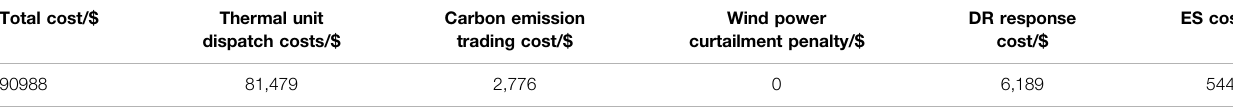
TABLE 5 | Daily operation costs of the system in Scenario 3 Total cost/$